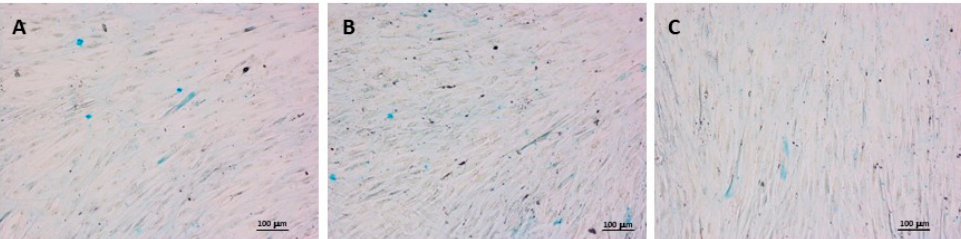
Figure 4. ( A – C ) Microphotographs of gingival fibroblasts cultured with vehicle ( A ), PN ( B ) or PN + HA ( C ) and stained with Alcian Blue. Magnification 10×, Bar = 100 μ m.